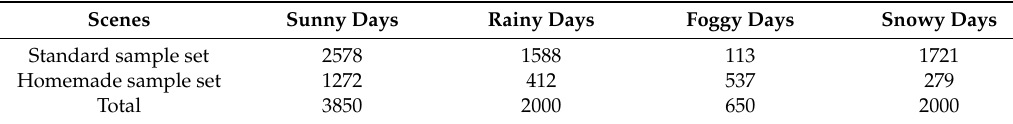
Table 3. The number of data in di ff erent weather conditions.